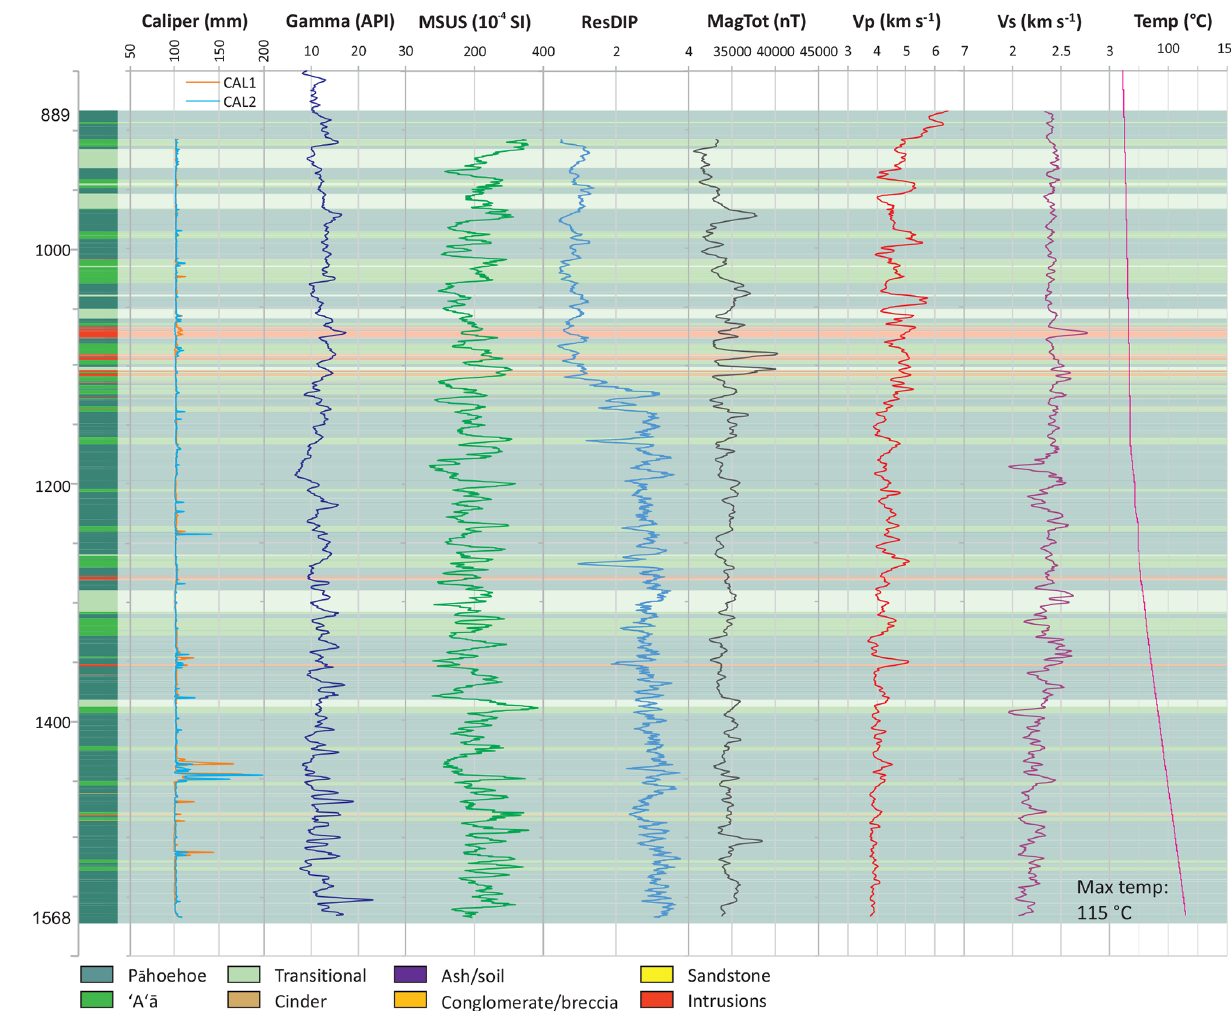
Figure 6. Summary of the full borehole logging results for PTA2.